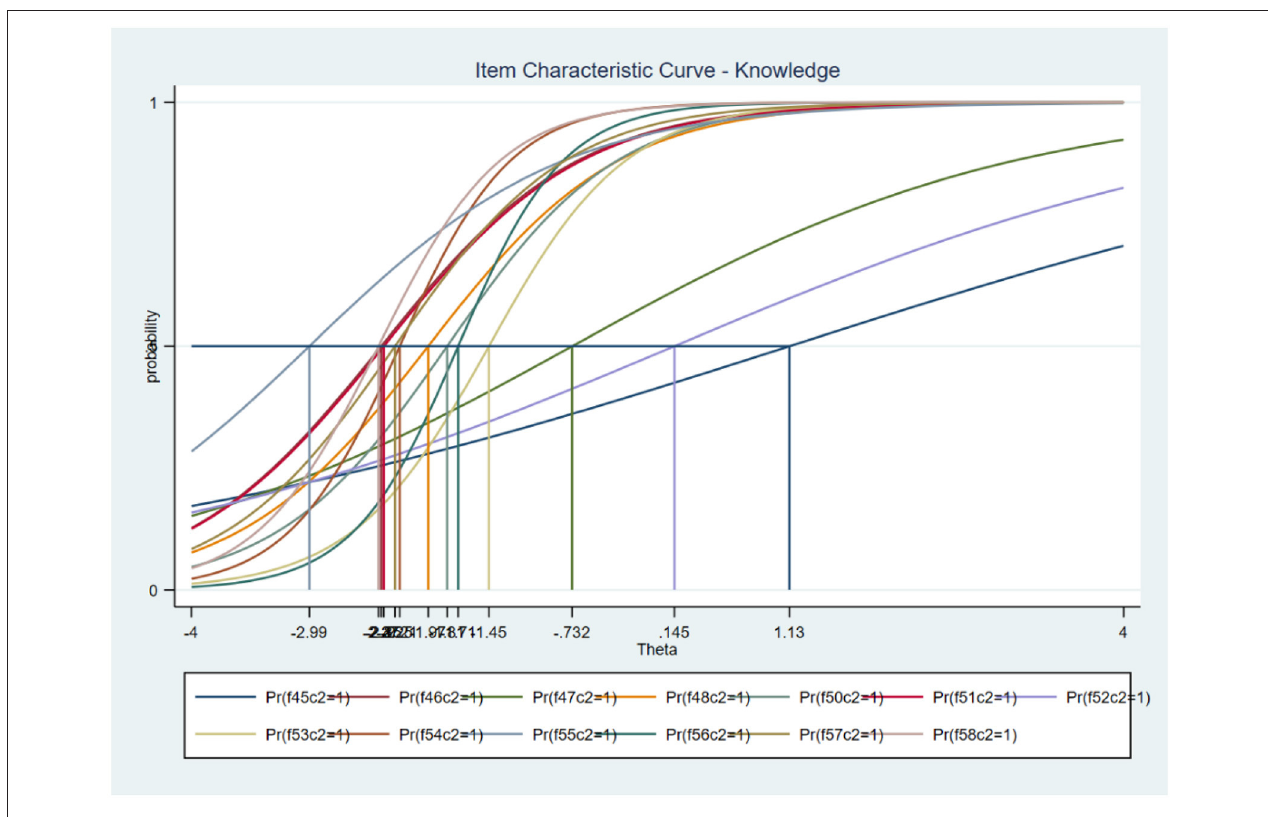
FIGURE 3 | Item characteristic curve.